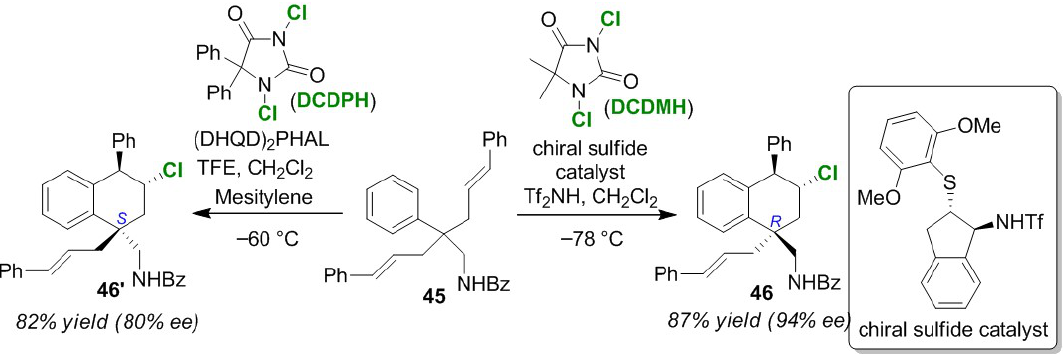
Figure 23. The catalyst-dependent enantioselective chlorocyclization aryl-tethered diolefin 45 .